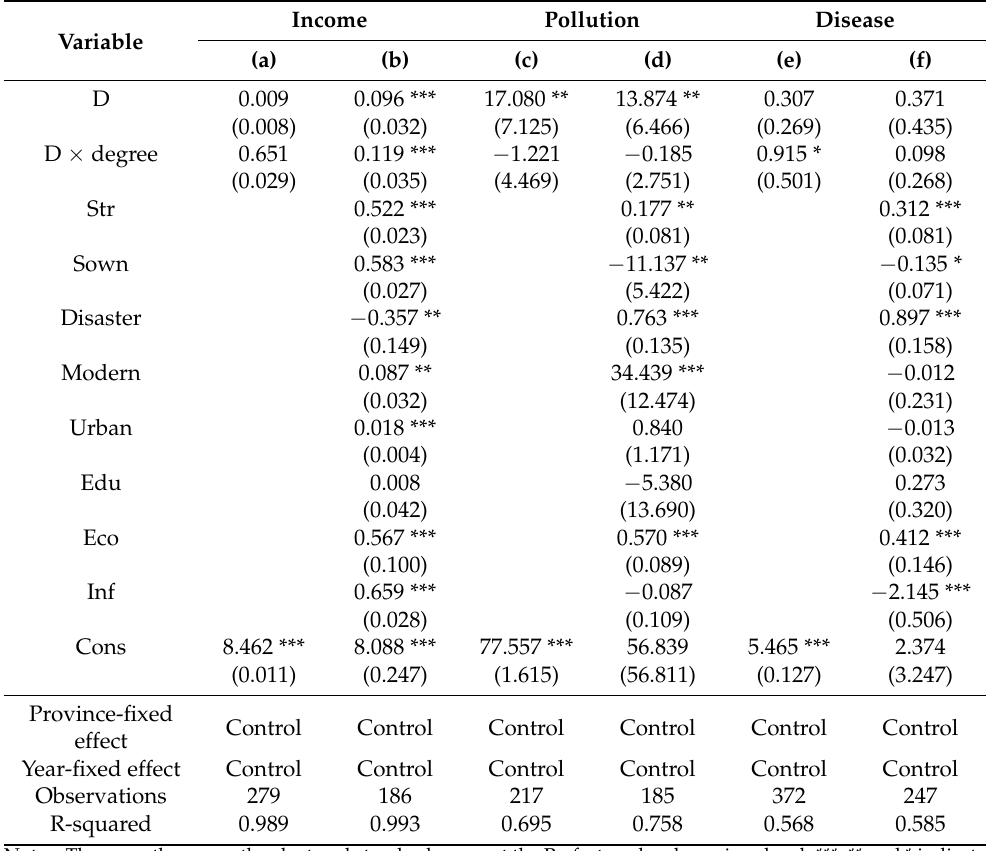
Table 9. Heterogeneity Analysis of Damage